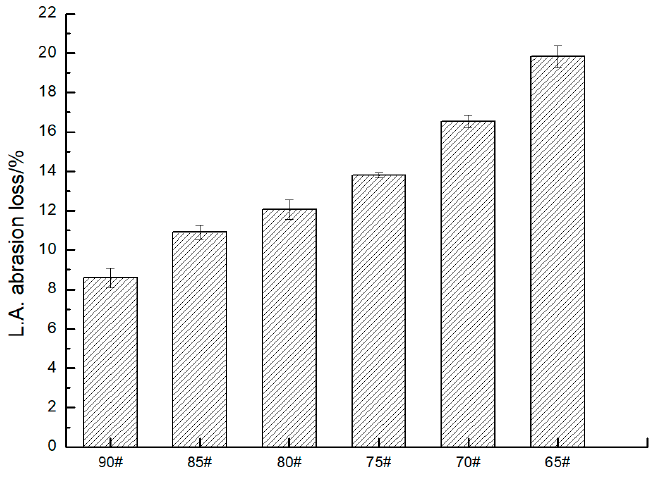
Figure 15. The results of the L.A. abrasion test.